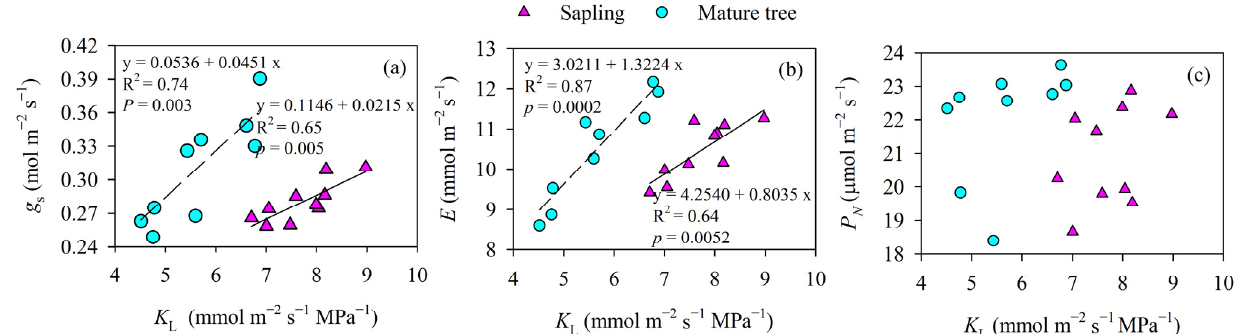
Figure 5. The relationship between leaf-specific apparent hydraulic conductance ( K L ) and stomatal conductance ( g s ) and the transpiration rate ( E ) and photosynthesis rate ( P N ) of P. euphratica at different sizes. Lines indicate significant linear regressions fit at a p value of <0.05. Asterisks indicate a significant difference in the slopes of g s versus K L between the size classes ( p < 0.05). ( a ) stomatal conductance; ( b ) transpiration rate; ( c ) photosynthesis rate.